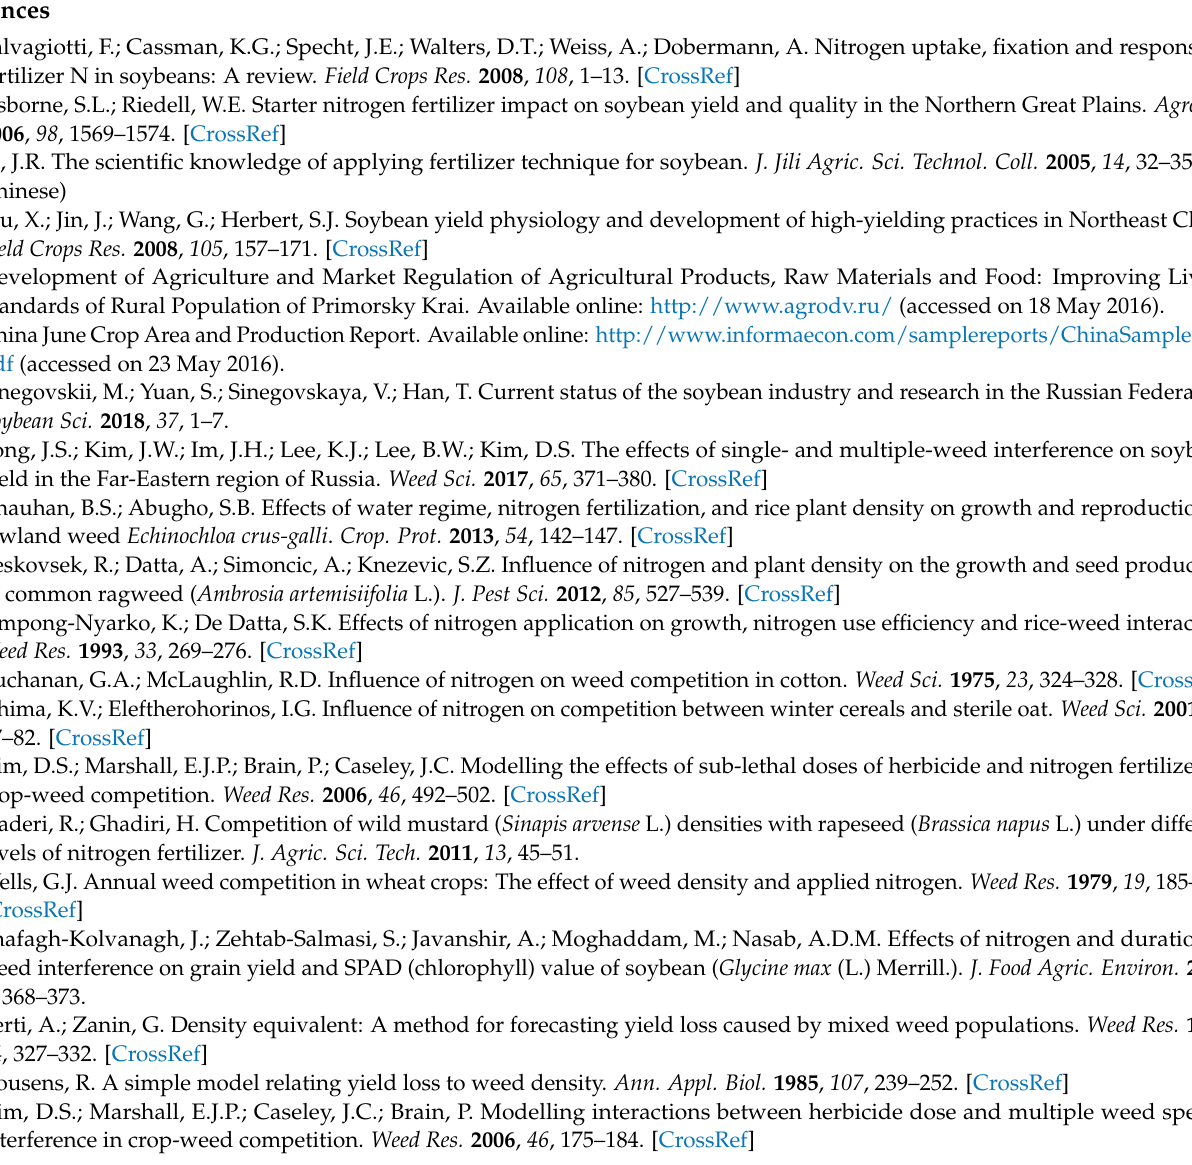
quadratic model, Figure S2: Weed competitiveness of Ambrosia artemisiifolia , Echinochloa crus-galli , and Beckmannia syzigachne as a function of applied nitrogen in 2013 ( ··· ) and 2014 (—) and for the pooled two-year (—) data presented in Table 1. The lines are fitted values calculated using exponential